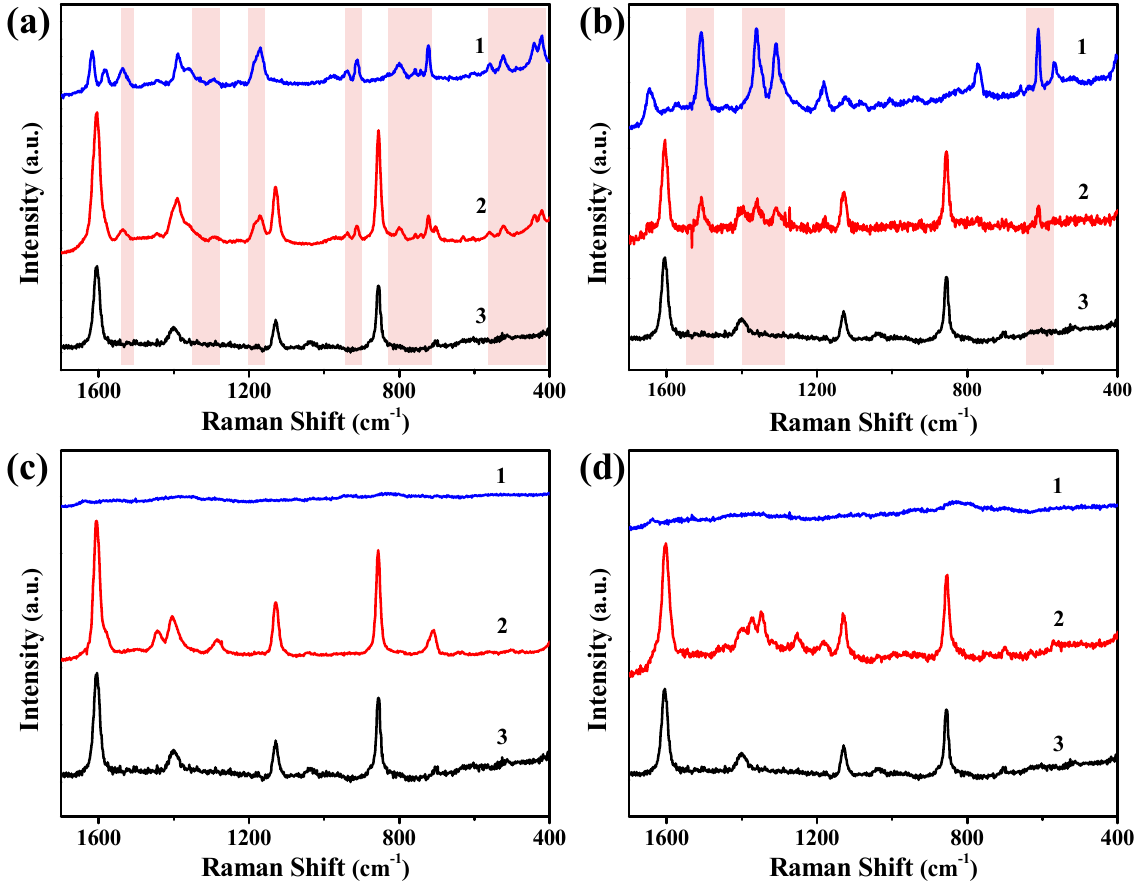
Figure 3. SERS spectra of the hydrophilic targets of ( a ) CV, ( b ) R6G, ( c ) TBBPA, and ( d ) Sudan Ⅰ obtained from the hydrophilic Ag chips (1) and the hydrophobic Cu-Ag chips (2), with the blank background of hydrophobic Cu-Ag chips (3) for comparison.